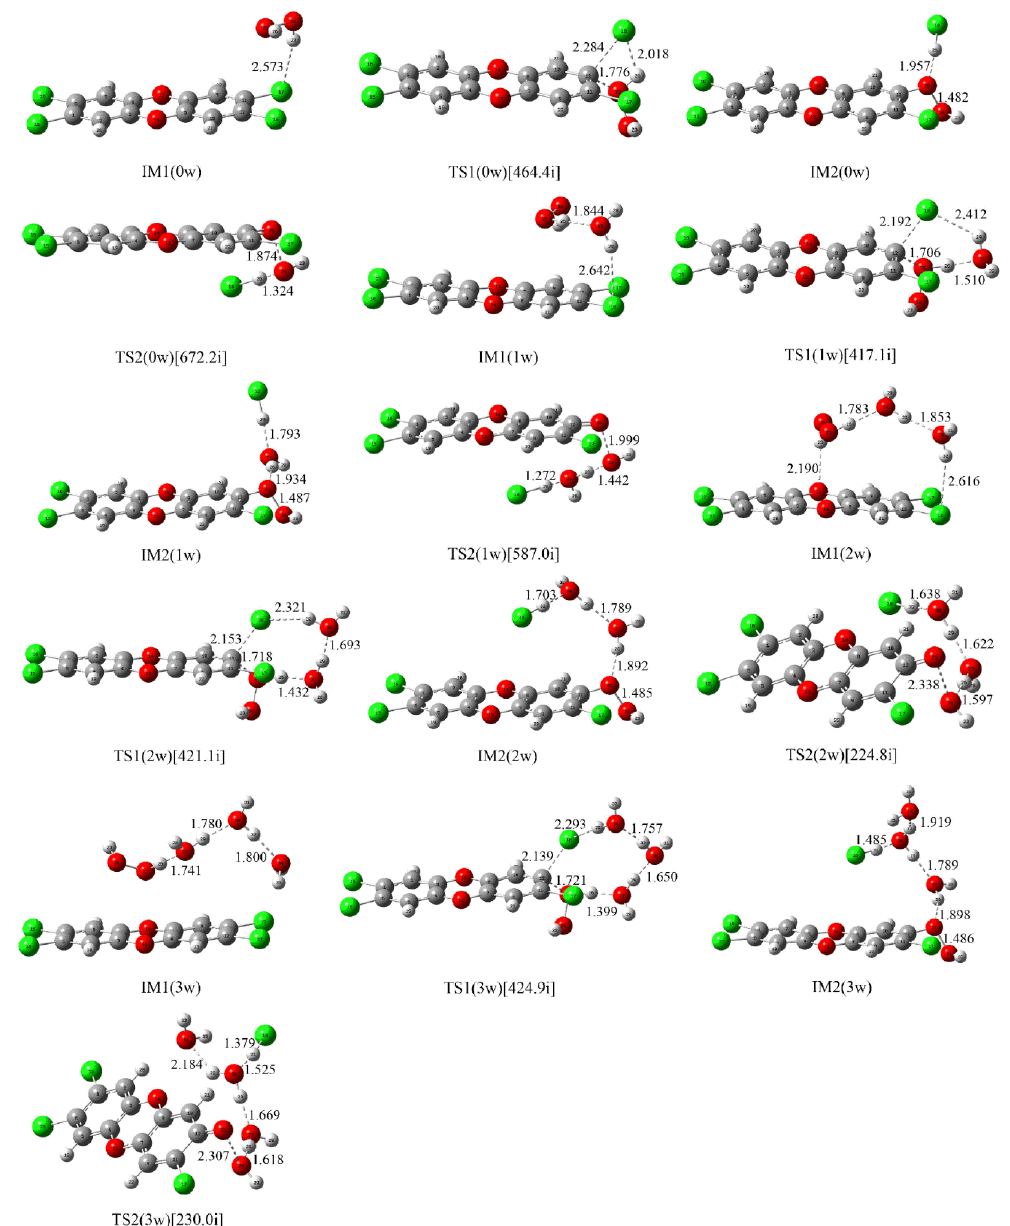
Figure 2. Optimized intermediates (IM) and transition states (TS) in the available reaction pathways of the reaction between neutral H 2 O 2 and TCDD.